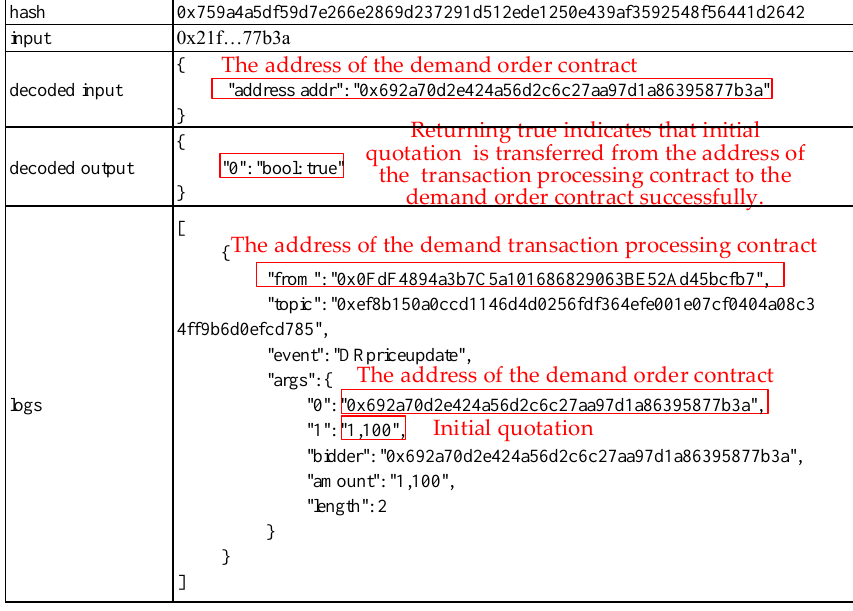
Figure 7. Record of transferred quoted price.